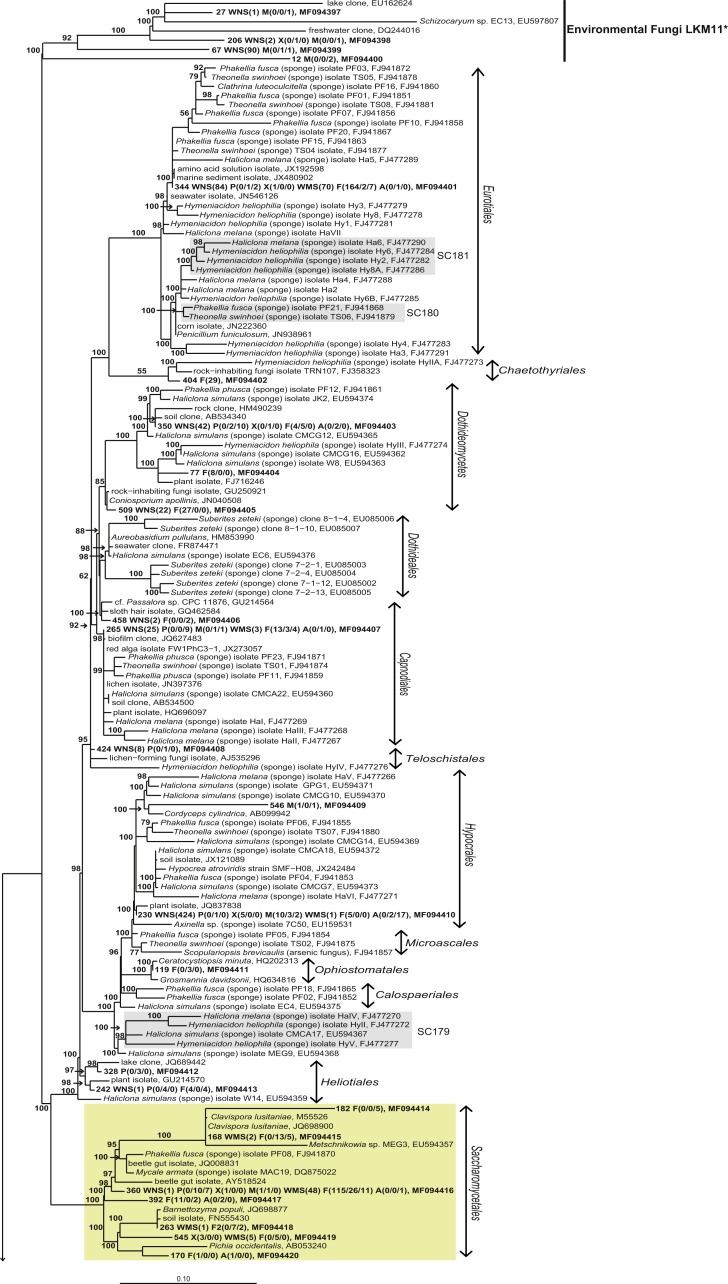
Bayesian phylogram of Ascomycota OTUs found in sponges based on 18S rRNA gene sequences.Other sequences included are (i) their nearest neighbors, and (ii) 18S rRNA sequences published by Simister et al. (2012) and Baker et al. (2009). Numbers in parentheses after the sample type indication refer to the absolute numbers of reads that were included in the corresponding OTU per sample (34 P(0/0/4) WMS(2) F(4/0/0) means that 4 reads of P3, 2 reads of Mediterranean seawater and 4 reads of F1 are included in OTU34). The NCBI genbank accession number is the last descriptor for each branch. Grey boxes indicate sponge-specific clusters (SSC) as defined by Simister et al. (2012). Yellow boxes represent yeasts. Taxonomic groups marked with an asterisk (*) indicate non-formal taxonomic classification (i.e., fungal environmental clade LKM11 is not a phylum, but a group assigned for environmental fungal-like sequences; Lara, Moreira & López-García, 2010). The numbers above or below the branches correspond to posterior probability (PP) values of the Bayesian analysis. Nodes with PP values of <50 are not indicated.